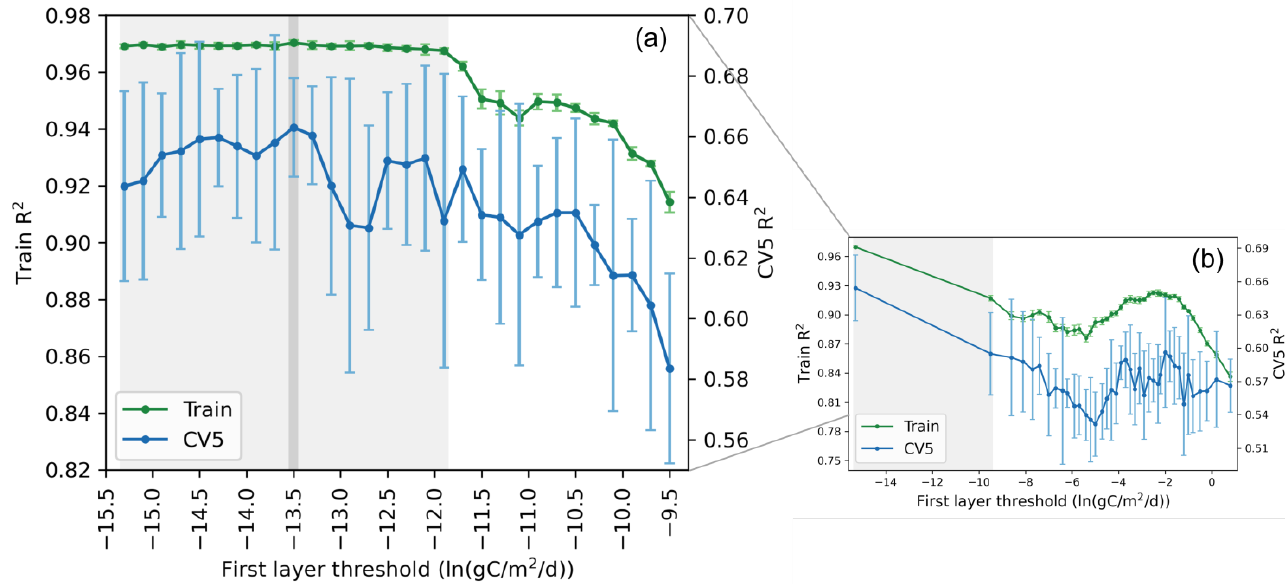
Figure 4. The relationship between the segmentation threshold of the first layer and the model’s accuracy. The horizontal axis represents the segmentation threshold of the first layer. The vertical axis represents 5-fold cross-validation R 2 and the R 2 on training set, respectively. Each point represents an average of 10 times independent training, and the error bar represents the standard deviation. ( a ) Shows the two evaluation indexes from − 15.3 ( ln⁡(gC/m 2 /d) ) to − 9.7 ( ln⁡(gC/m 2 /d) ), which is the details of gray part in ( b ), and ( b ) shows the R 2 from − 15.3 ( ln⁡(gC/m 2 /d) ) to 0.8 ( ln⁡(gC/m 2 /d) ) with a step of 2.5% of total samples.